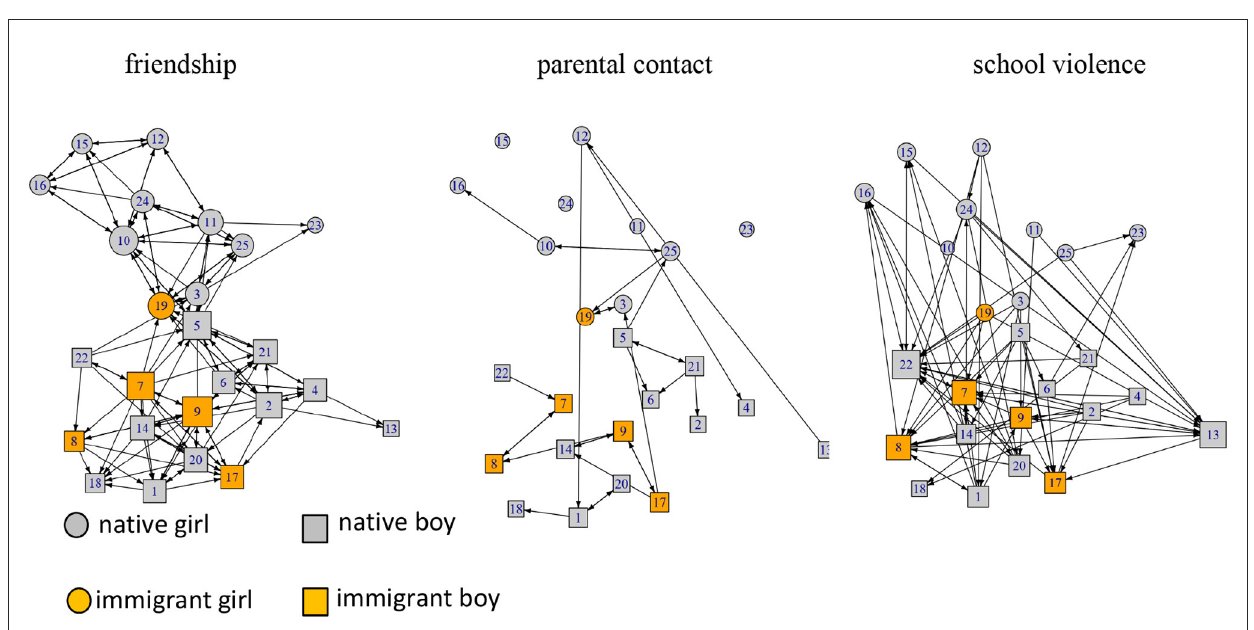
FIGURE3 Example of network dimensions of “friendship,” “parental contact” and “school violence”.